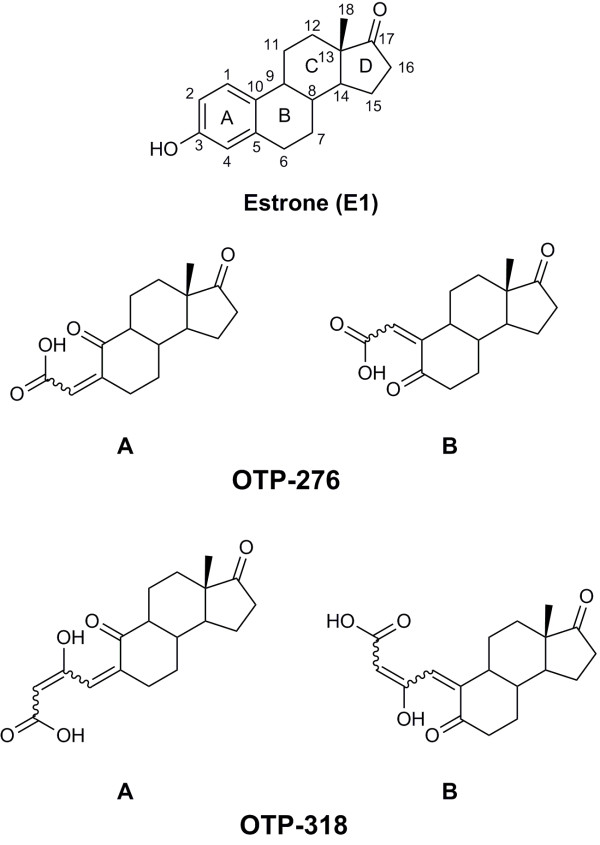
Molecular structure of estrone (E1) showing the standard C atom numbering and two possible structures for each of the identified OTPs. OTP-276B was not observed, while OTP-318B was 10 times less abundant than OTP-318A. Wavy bonds indicate that the exact stereochemistry is unknown.